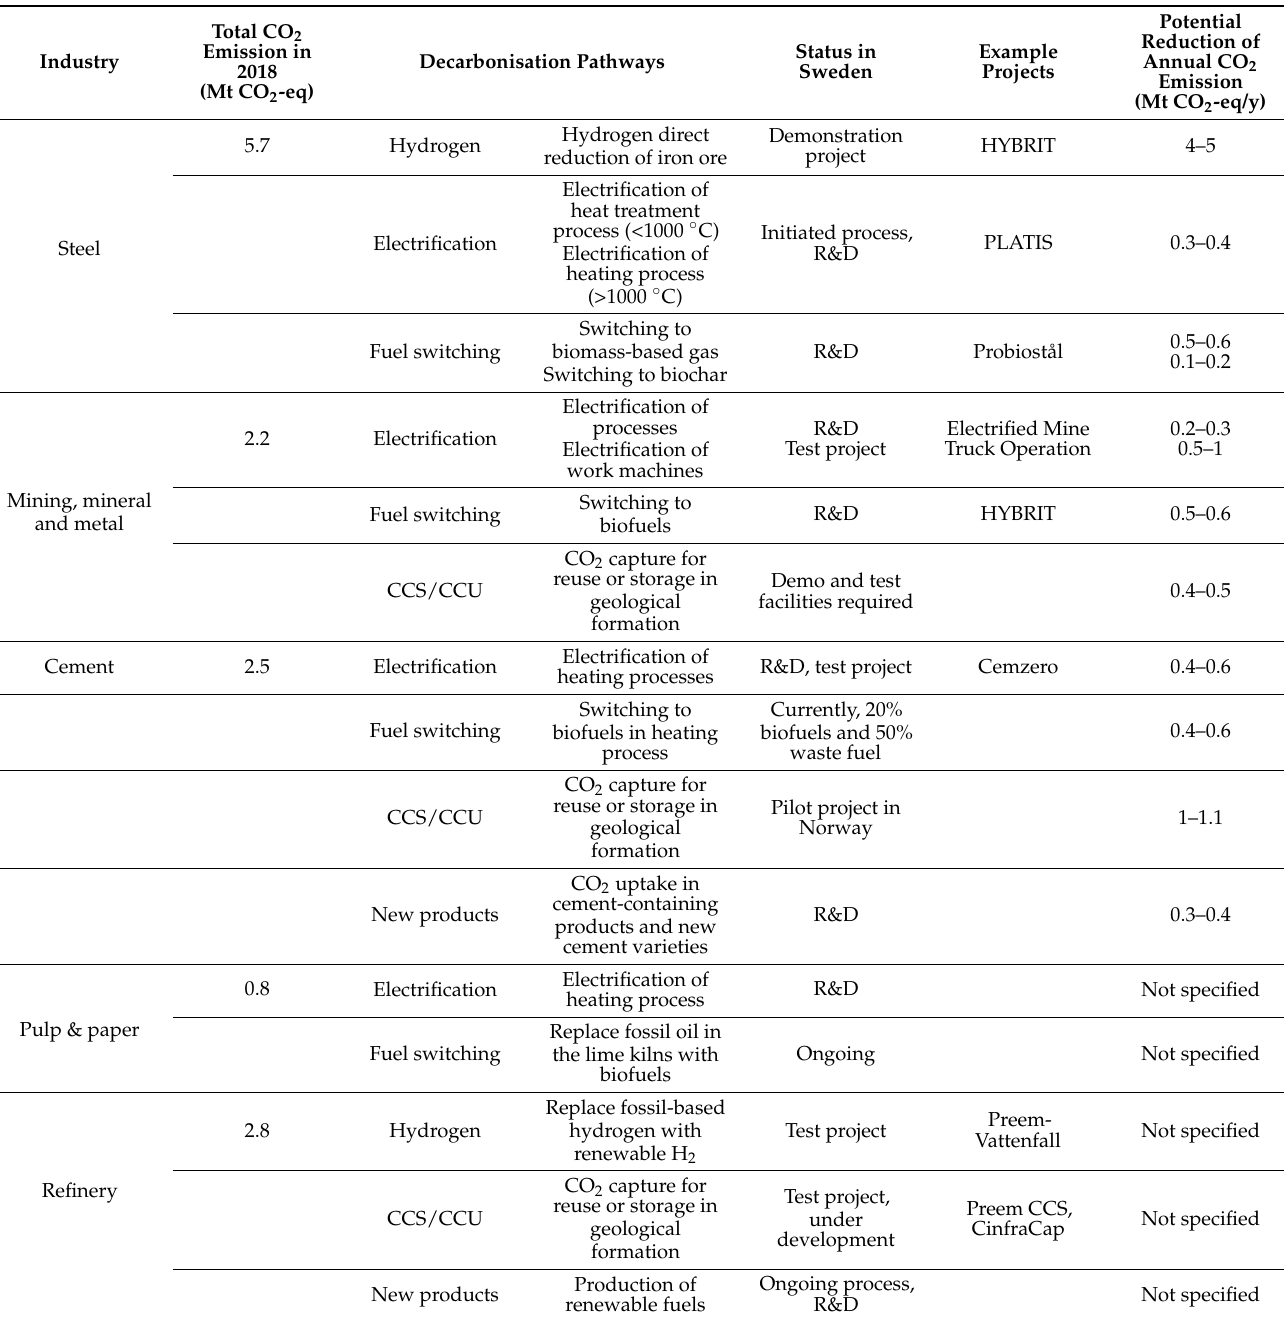
Table 5. Compilation of industrial climate action plans within the framework of the Fossil-Free Sweden initiative for decarbonising energy-intensive industries (compiled from: [68,77,93,113,114]).